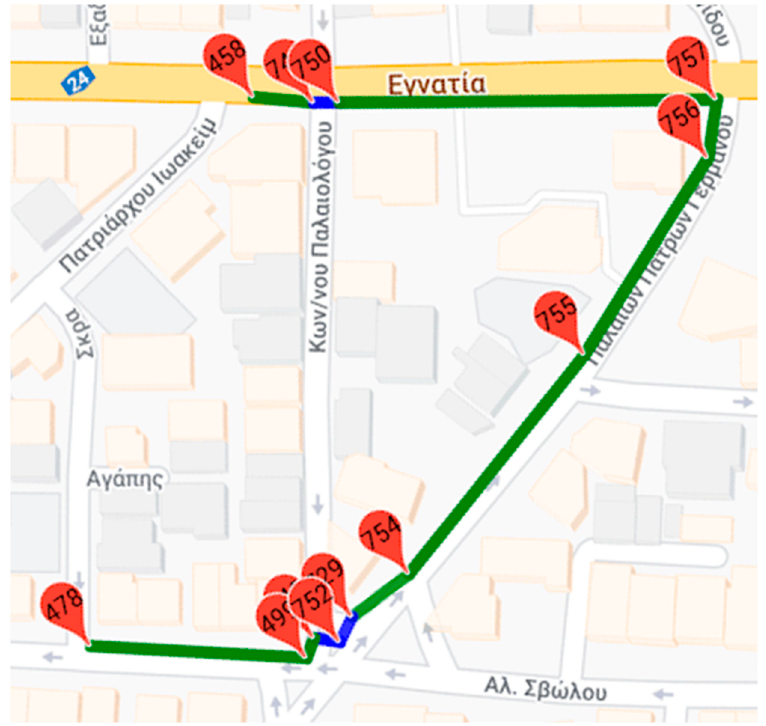
Figure 11. Most accessible path between nodes 458 and 478 using 2nd version of the